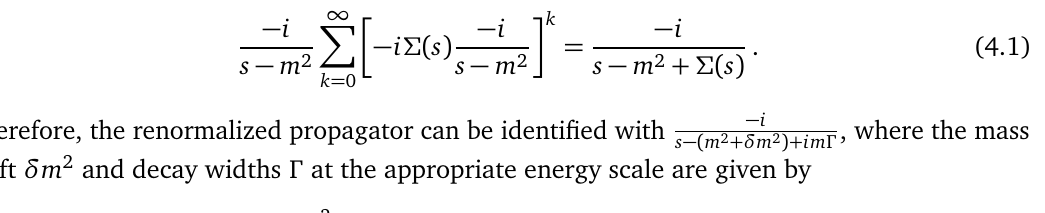
Figure 12: Numerical plot of the type II amplitude (3.77) in the ( s , t ) -plane obtained = 1 and normalized by 2 5 ˜ t t by setting g 4 8 8 s the double poles at s , t , u =